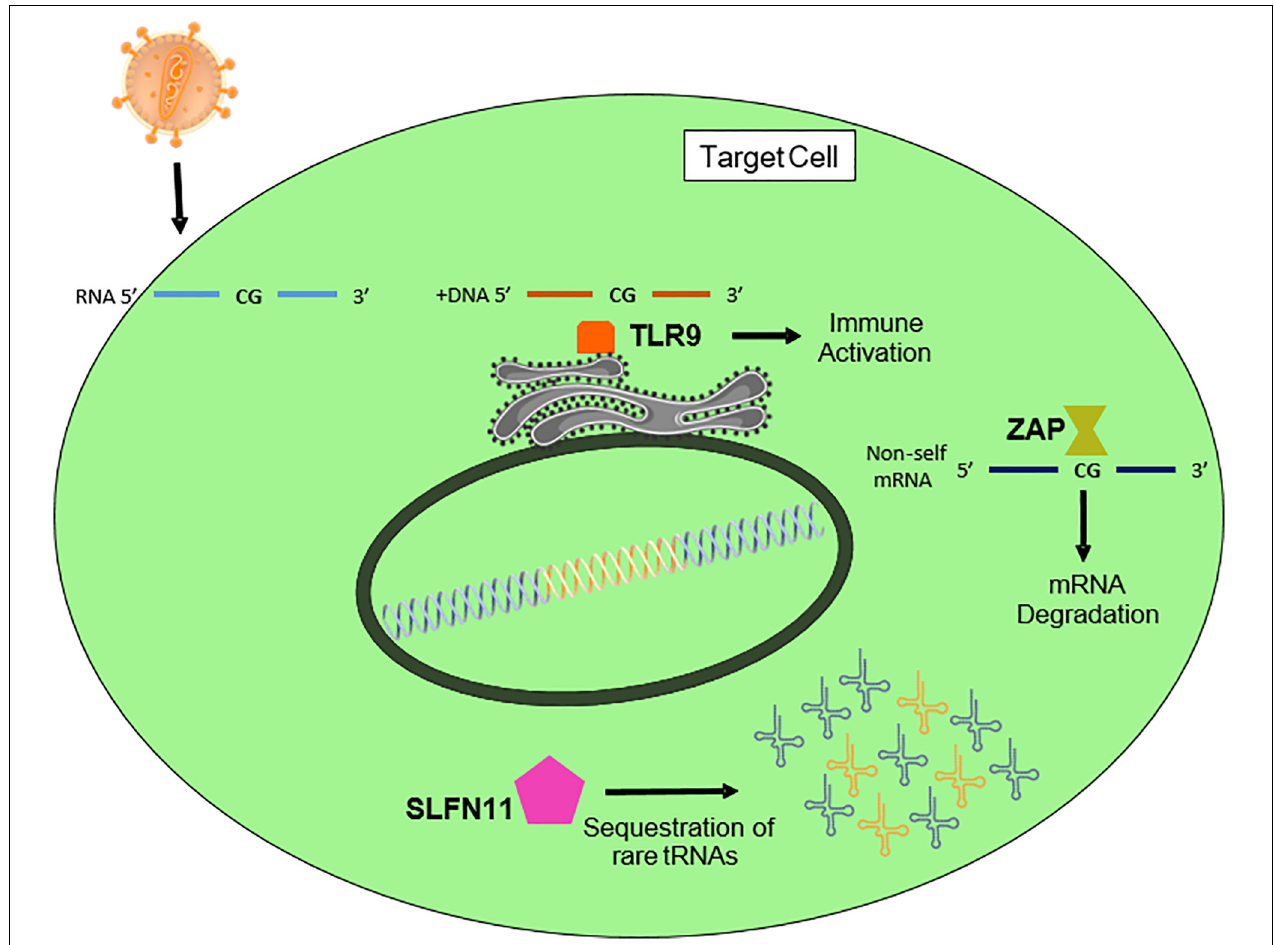
FIGURE 4 | Factors of the innate immune system that might affect the nucleotide composition of the HIV-1 genome. SLFN11 sequesters tRNAs in a codon-dependent manner. Toll-like receptor 9 recognizes unmethylated CpGs in DNA, and activates the immune cascade (Pandey et al., 2015). Finally, ZAP recognizes CpG-rich non-self RNAs and induces their